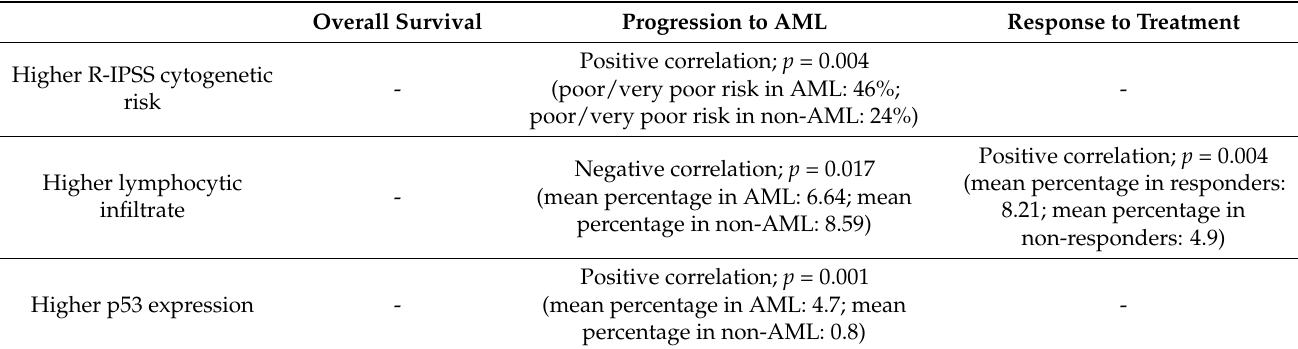
Table 3. Pre-treatment biopsy prognostic